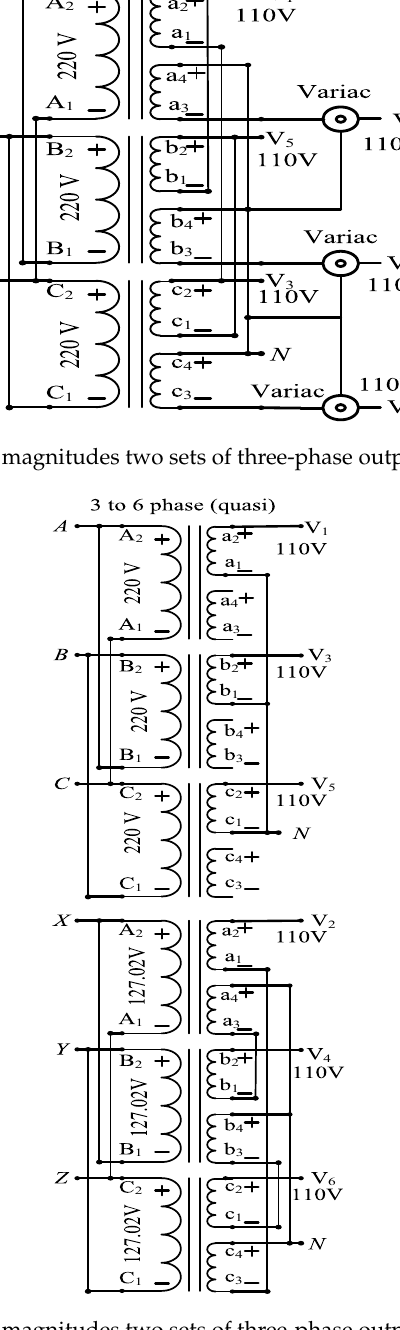
Figure 9. Obtaining equal magnitudes two sets of three-phase outputs with 30 ° phase shifts.